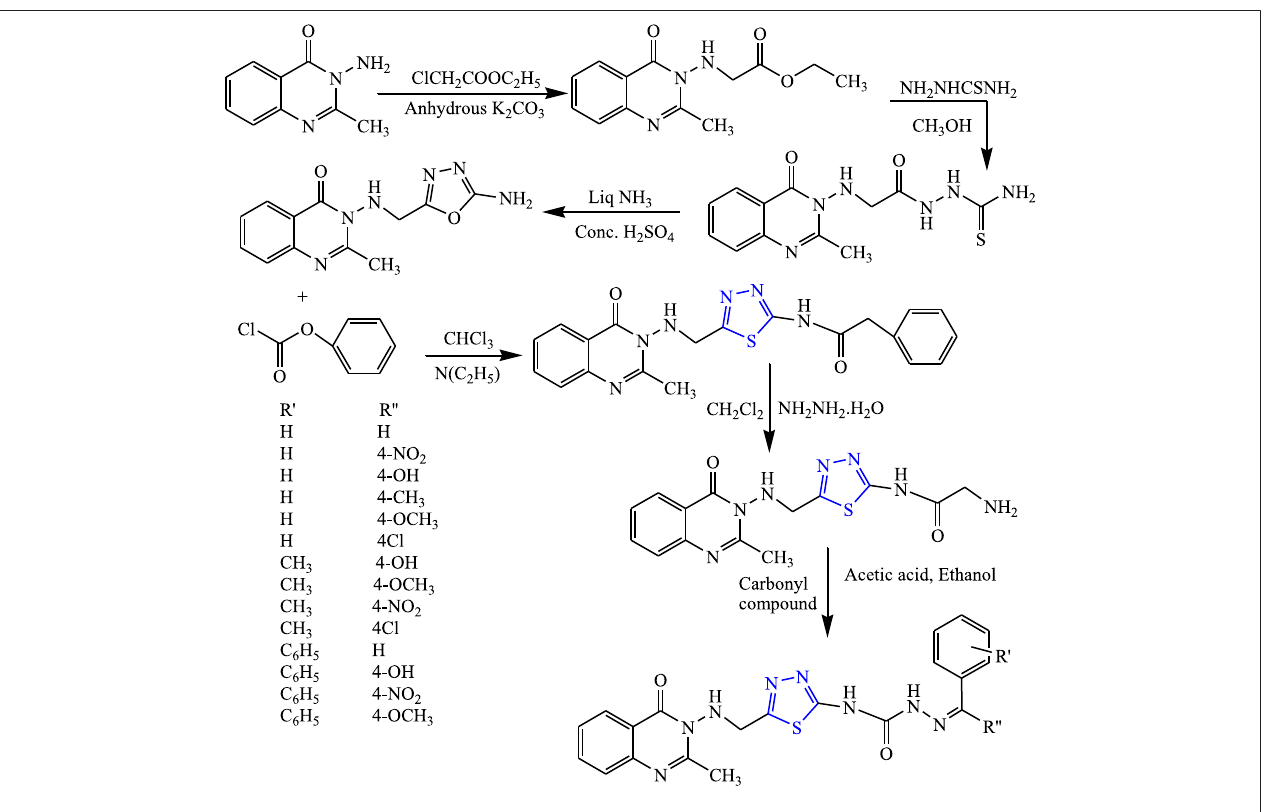
FIGURE 18 | Systematic scheme for synthesizing 1,3,4-thiadiazole quinazoline analogs.